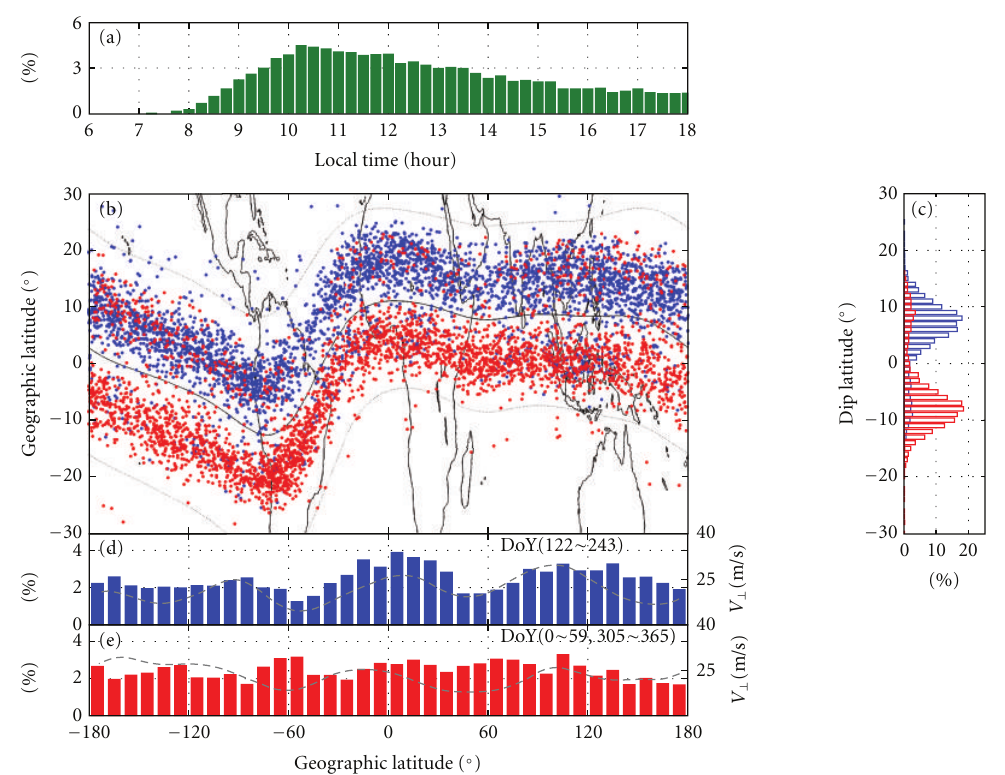
Figure 14: F3 layer occurrence as a function of (a) local time, (b) geographic position of the F3 layer during 06:00–18:00 LT in boreal summer (blue) and winter (red), (c) dip latitude, (d) geographic longitude during boreal summer, and (e) winter. ROCSAT-1-derived equatorial vertical drift V ⊥ (gray) was superimposed on (d) and (e) (from Zhao et al. [55]).